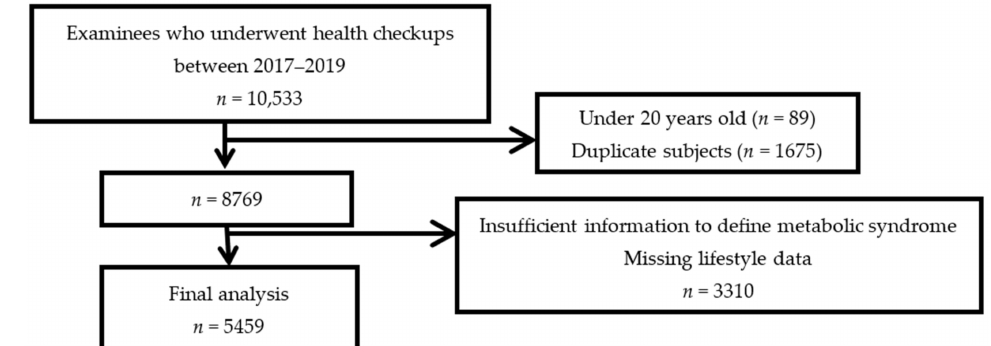
Figure 1. Flowchart of the selection of the study